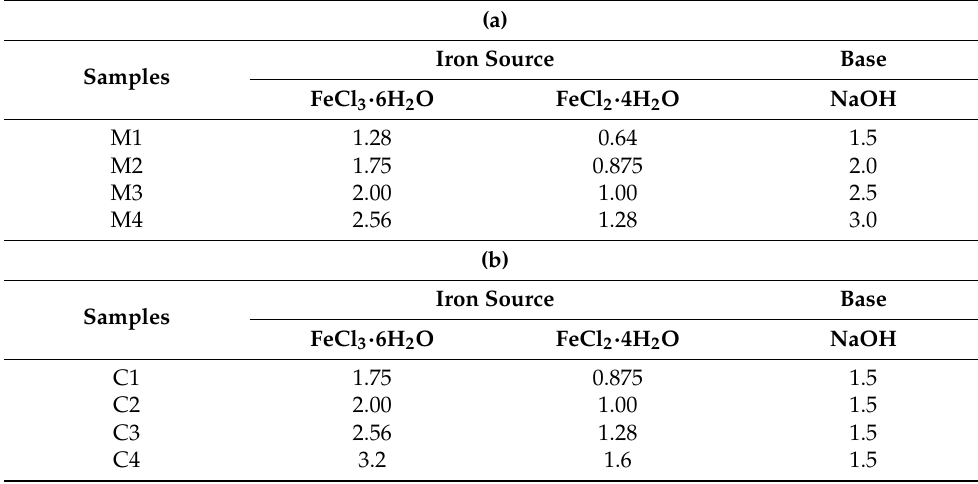
Figure 1. Flowchart of the synthesis of core magnetite nanoparticles. The entire process was repeated by varying (increasing) the molarities (M2, M3, and M4) of the iron sources (FeCl 3 .6H 2 O and FeCl 2 .4H 2 O) and the base (NaOH). The detailed molarity values are shown in Table 1a. Table 1. ( a ) Molarity values of FeCl 3 .6H 2 O, FeCl 2 .4H 2 O, and NaOH for samples M1 to M4. ( b ) Molarity values of FeCl3.6H2O, FeCl2.4H2O, and NaOH for samples C1 to C4.